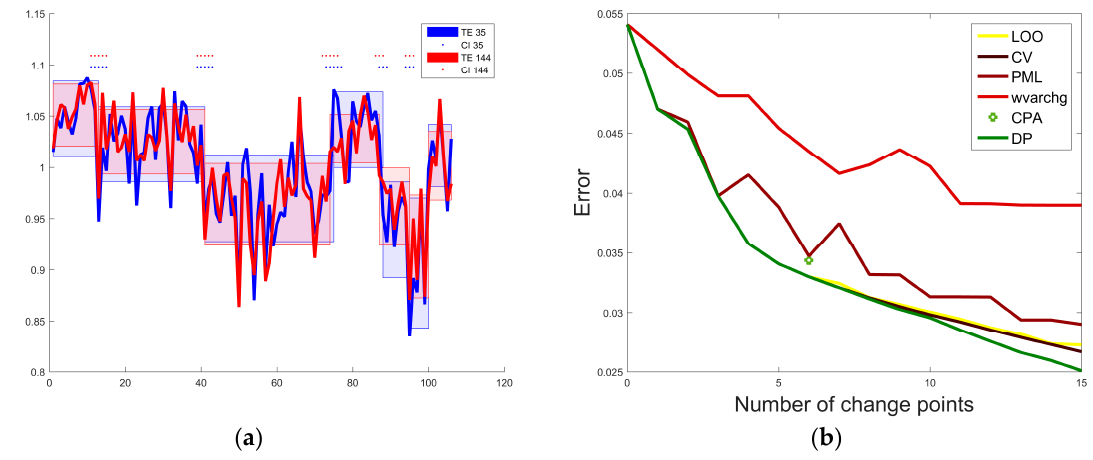
Table 2. Mean values (mean) and standard deviation (std) of full width at half maximum (FWHM), signal-to-noise ratio (SNR) and transmitter gain (TG) of the spectra averaged for the time intervals detected by the change point analysis. FWHM and SNR (the ratio of the maximum in the spectrum- minus baseline over the analysis window to twice the root mean squares of residuals) are the main spectral quality parameters determined with use of Linear Combination Model (LCModel) [24].